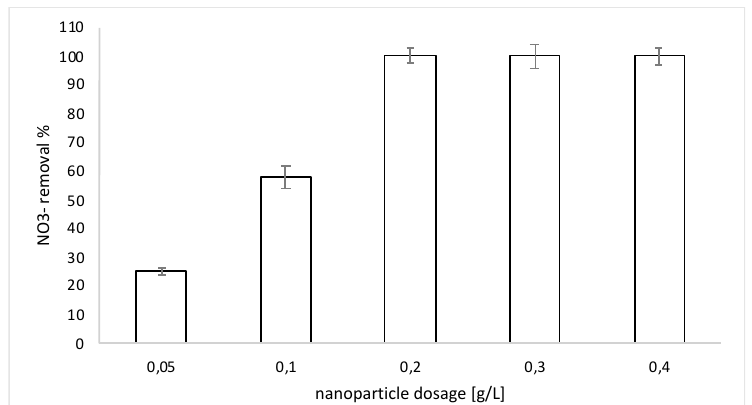
Figure 6. Nitrate removal at different dosages of bimetallic nanoparticles. Condition: unbuffered pH, T = 298 K, and [NO 3 − ] = 300 mg L − 1 .